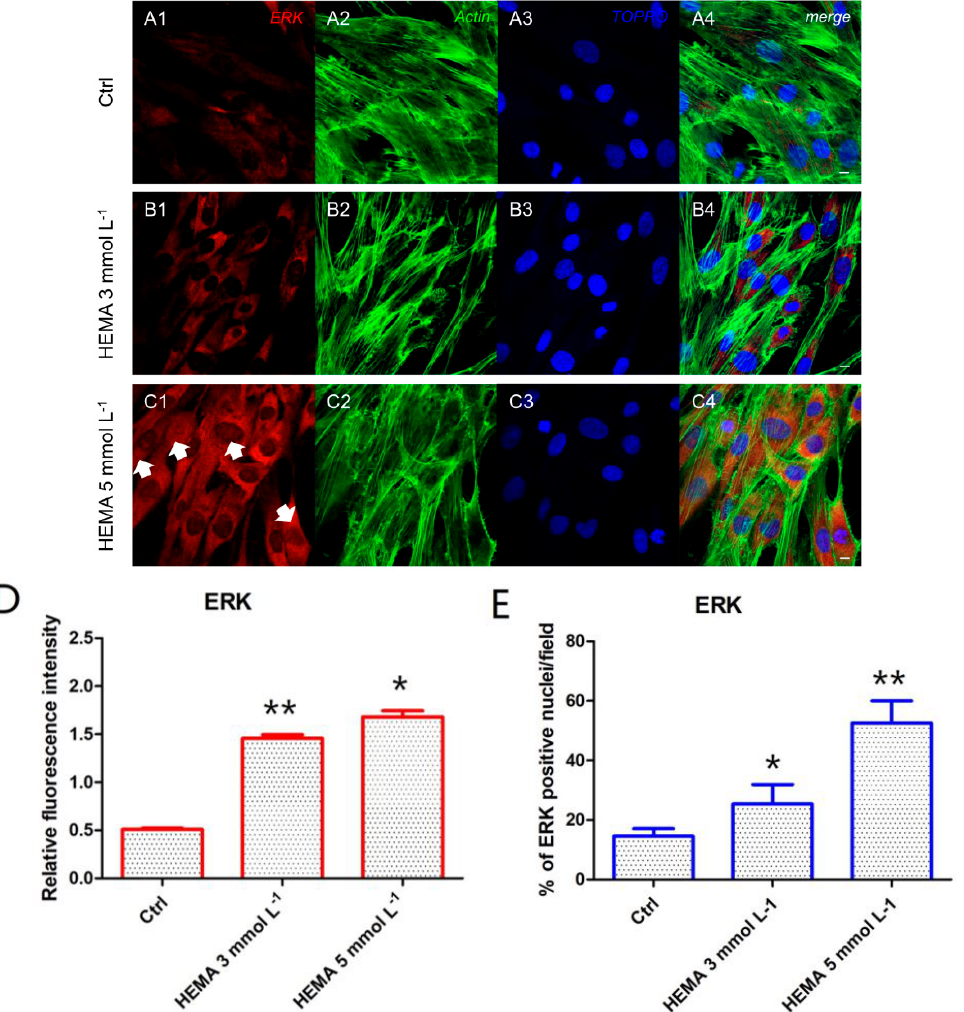
Figure 5. ERK expression. ( A1 ) Untreated cells showed a low positive expression for ERK. ( A2 ) Actin cytoskeleton in untreated hDPSCs. ( A3 ) Nuclei in untreated hDPSCs. ( A4 ) Merged picture of abovementioned channels in untreated hDPSCs. ( B1 ) Cells treated with HEMA 3 mmol L − 1 showed a positive expression for ERK. ( B2 ) Actin cytoskeleton in HEMA 3 mmol L − 1 treated hDPSCs. ( B3 ) Nuclei in HEMA 3 mmol L − 1 treated hDPSCs. ( B4 ) Merged picture of abovementioned channels in HEMA 3 mmol L − 1 treated hDPSCs. ( C1 ) Cells treated with HEMA 5 mmol L − 1 showed a strong positive expression for ERK, with a nuclear localization (arrows). ( C2 ) Actin cytoskeleton in HEMA 5 mmol L − 1 treated hDPSCs. ( C3 ) Nuclei in HEMA 5 mmol L − 1 treated hDPSCs. ( C4 ) Merges picture of abovementioned channels in HEMA 5 mmol L − 1 treated hDPSCs. ( D ) The relative fluorescent intensity of ERK was analyzed using NIS-Elements AR imaging software. Data are presented as the mean of 30 measurements ± standard deviation. ( E ) Analysis of the percentage of ERK-positive nuclei / field. * p < 0.05; ** p < 0.01. Green fluorescence: actin cytoskeleton, red fluorescence: ERK, blue fluorescence: nuclei. Magnification: 63 × . Scale bar: 10 μ m.